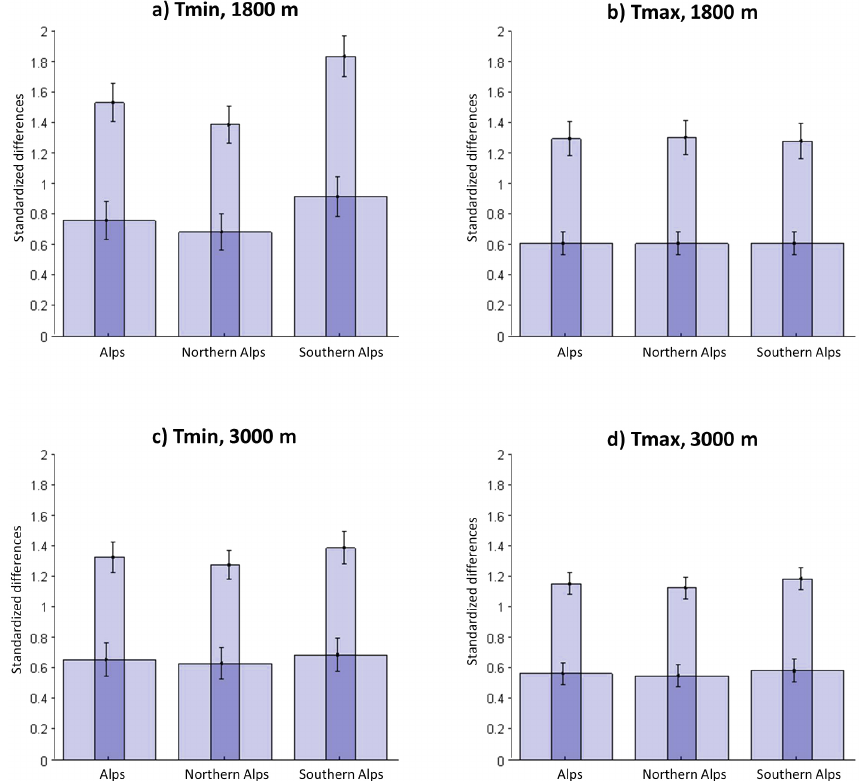
Figure 4. Standardized differences (differences between reference and future-period means divided by the variability range for the reference period) in temperatures (minimal/maximal, at 1800 and 3000ma.s.l.) on the scale of the entire French Alps and for the whole year for the middle and end of the 21st century (wide and thin bars, respectively) for the A1B scenario. Error bars ( ± 1.5 σ) represent interannual